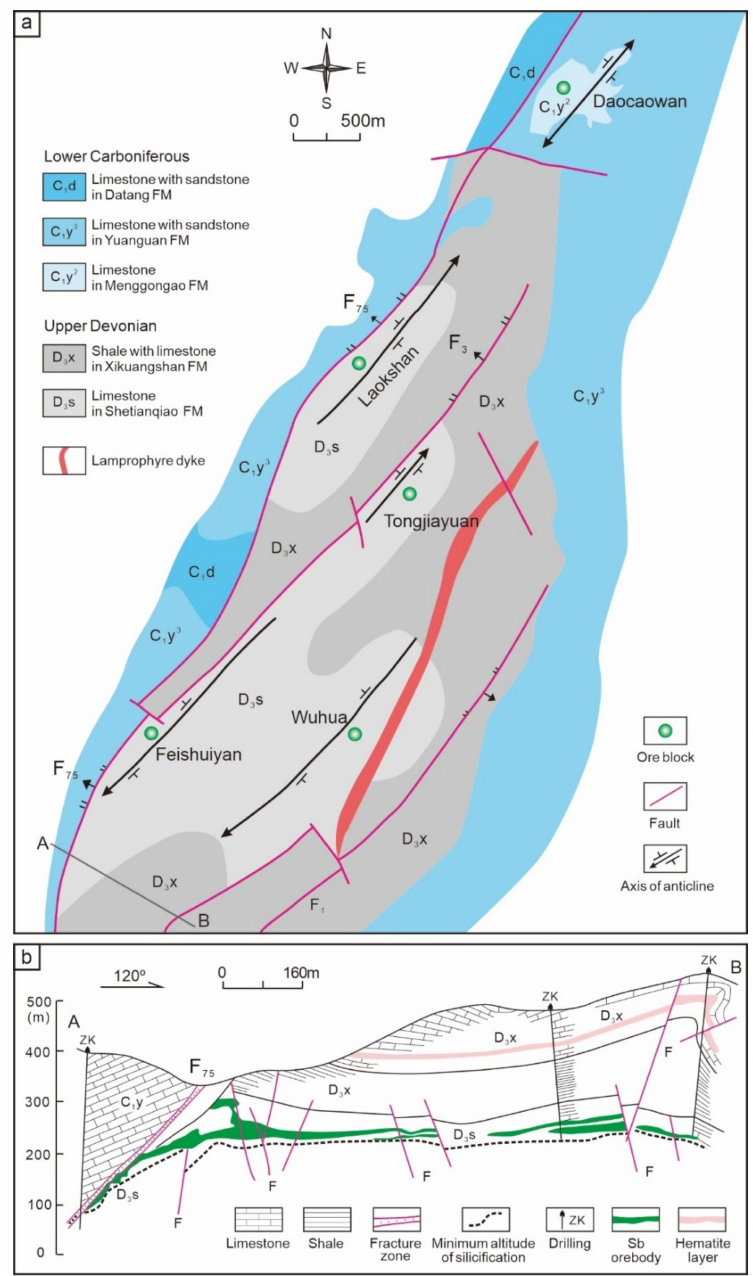
Figure 2. ( a ) Simplified geologic map of the Xikuangshan Sb deposit (modified after [27]). There are five ore blocks in the Xikuangshan Sb deposit: Daocaowan, Laokuangshan, Tongjiayuan, Wuhua, and Feishuiyan. ( b ) A representative section of the Xikuangshan Sb deposit showing the geological and geometric characteristics of Sb orebodies (modified after